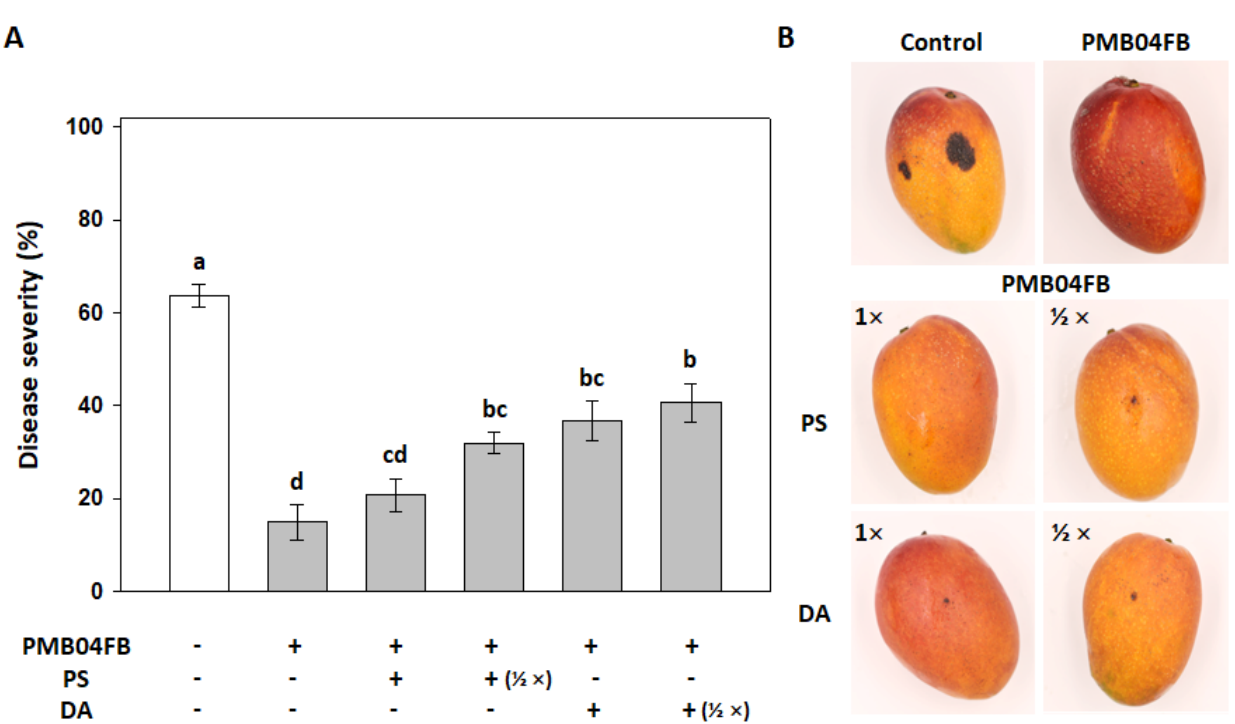
Figure 5. Control of combined Bacillus amyloliquefaciens PMB04 fermentation broth and fungicides against anthracnose disease in mango fruit. ( A ) shows the disease severity at 7 days post-inoculation. The surfaces of sterilized fruit were soaked in the 200-fold dilution of B. amyloliquefaciens PMB04 fermentation broth (PMB04FB) containing a full (1 × ) or half dose (1/2 × ) of pyraclostrobin (PS) or difenoconazole (DA) for 1 min as the treatment. The symbols “+” and “ − ” indicate the inclusion and exclusion, respectively, of the treatments. A negative control was performed with sterilized water alone. A spore suspension of Colletotrichum gloeosporioides was then spotted on the surface of the fruit for inoculation. Data represent mean ± SD. Different letters above the columns indicate significant differences based on Tukey’s HSD test ( F = 36.9; p < 0.05). ( B ) displays the symptom appearances of the different treatments on fruit.